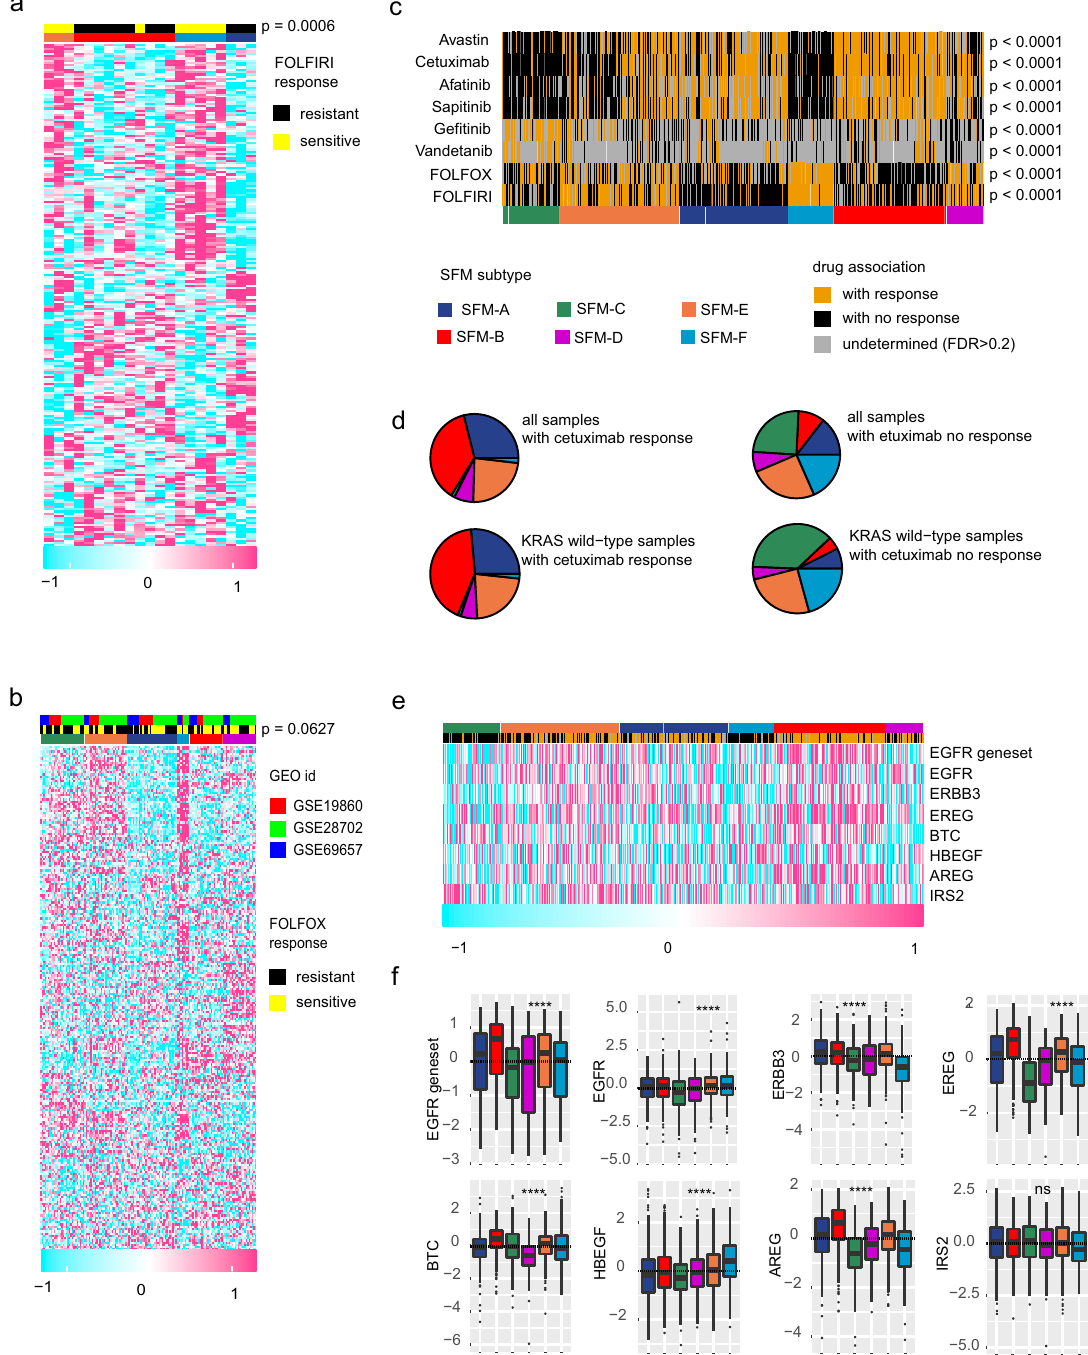
Fig. 2 Distinct sensitivity among SFM subtypes to FOLFIRI and FOLFOX chemotherapy regimens and RGFR inhibitors. a Heatmap showing individual response of patients to FOLFIRI and their association with subtypes in GSE62080 dataset ( n = 21). P value was calculated using Chi- squared test. b Heatmap showing individual responses of patients to FOLFOX and their association with subtypes in combined three GEO datasets (GSE19860, GSE28702, and GSE69657, n = 142). P value was calculated using Chi-squared test. c Heatmap showing association of individual CRC patient ’ s response to FOLFIRI, FOLFOX, and EGFR inhibitors. In these analyses, samples with FDR < 0.2 were regarded as signi fi cant. d Prevalence of SFM subtypes regarded as sensitive or resistant to cetuximab in all CRC patients ( n = 1752) or only in KRAS wild- type patients ( n = 637). e Heatmap showing response to cetuximab, quanti fi ed expression of gene set of the EGFR pathway activity by applying GSVA and expression of individual genes of the EGFR gene set among SFM subtypes. f Box plots of the EGFR gene set and individual genes of the EGFR gene set among SFM subtypes. Box hinges represent fi rst and third quartiles, and middle represents the median. The upper and lower whiskers extend from hinges up and down indicate the most extreme values that are within 1.5 × IQR (interquartile range) of the respective